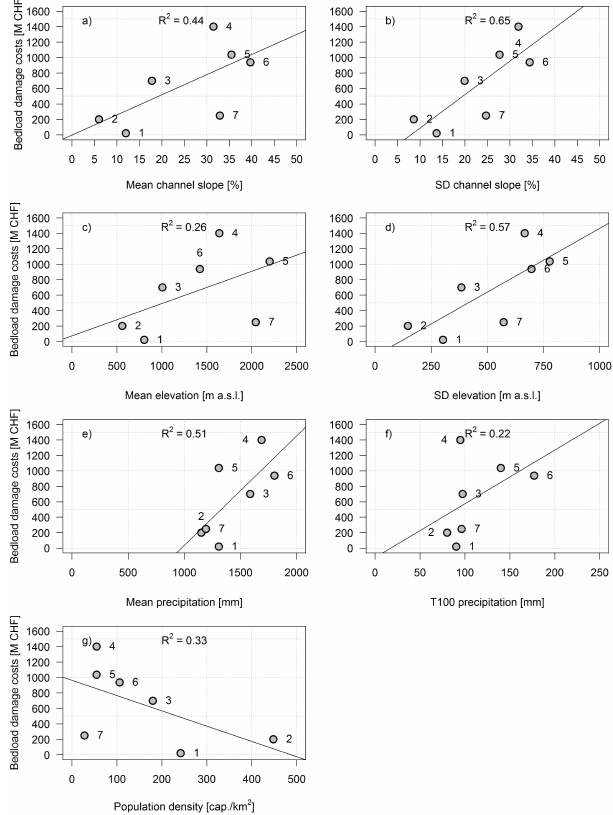
Fig. 7. Relation, for the seven different subareas, between the frac- tion of bedload damage costs to total costs and (a) the mean/ (b) standard deviation of channel slope, (c) the mean/ (d) standard de- viation of elevation, (e) the mean annual precipitation, (f) the 1-day rainfall with a recurrence interval of 100yr, and (g) the population density. Note that the average of the lower and upper estimates was applied to determine the fractions. Numbers next to the data points denote subareas according to Table 1 and Fig.